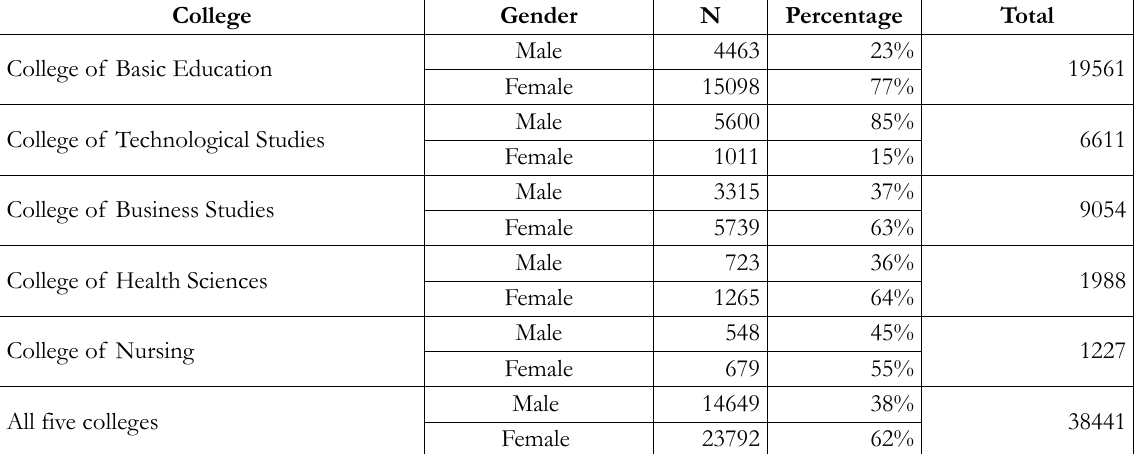
Table 1. The research population based on gender